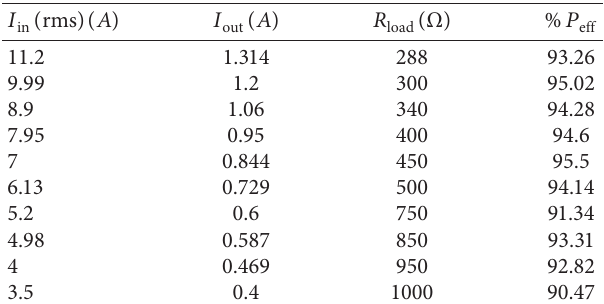
Figure 16: (a) Efficiency vs output power. (b) Measurement results: loss distribution on the main components of the converter at 100W power. (c) SISO mode comparison of the proposed converter with other converters with n � 2. (d) Efficiency comparison of the converters. Table 4: Power results in mode 1 with V � 48V, pv � 260V , and V � 96 V 0 bat